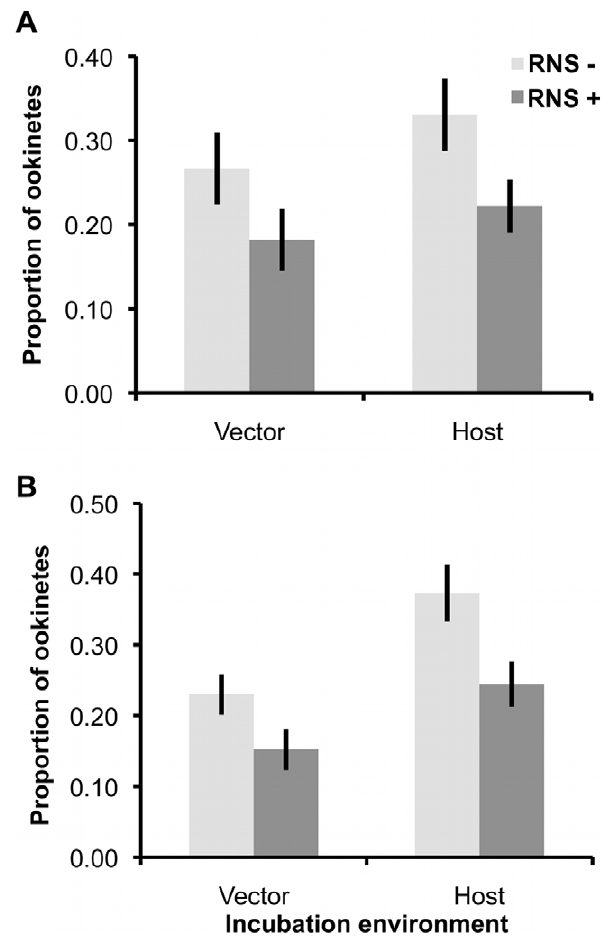
Figure 4. Ookinete production after exposure of males or females to RNS, before or during gametogenesis. Mean ( 6 S.E.) proportion (n=19) of ookinetes produced, when females (A) or males (B) are exposed to RNS as gametocytes (in-host conditions media) or during gametogenesis (in-vector conditions media). Proportions are relative to the total number of ookinetes produced by the focal sex from each pair of infections.